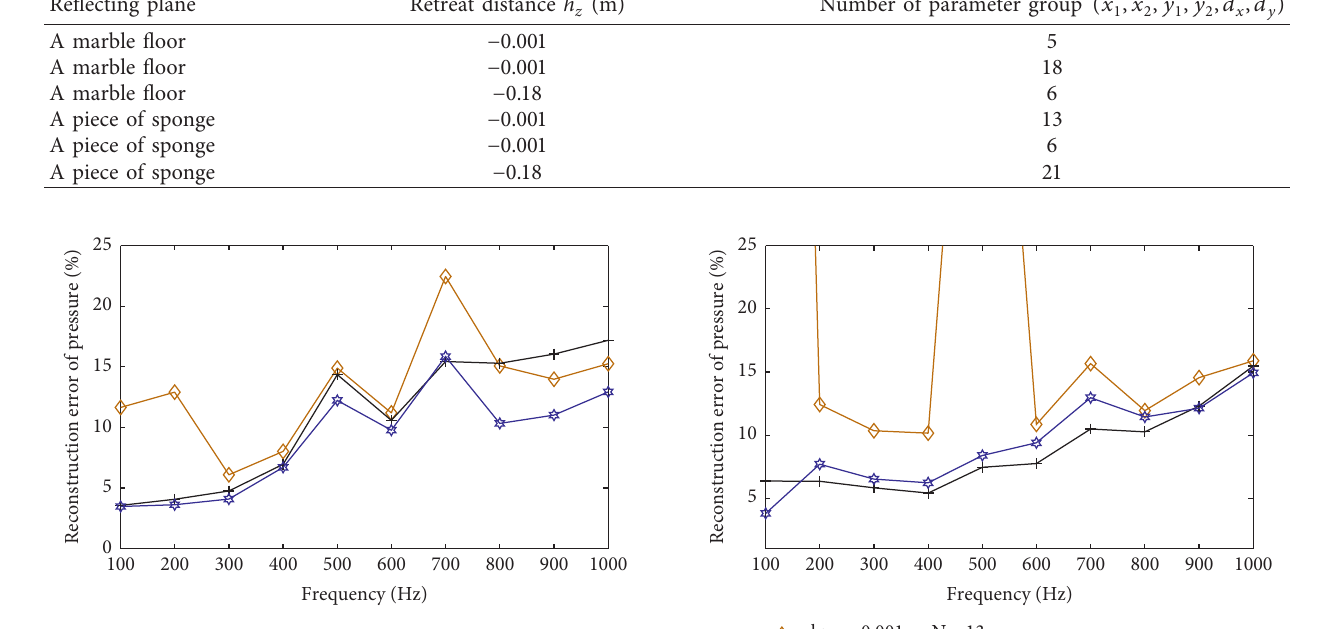
Figure 8: The reconstruction errors of pressure when using different CRP configurations with a piece of sponge as the reflecting plane. Table 4: Equivalent source configurations for confirmation in experiments. Reflecting plane